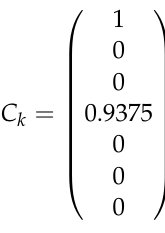
Table 6. Final scores and ranked list of books on Data Structure using OWA (most preferred first). Rank Position Book Code 1st DS.9. 0.4642